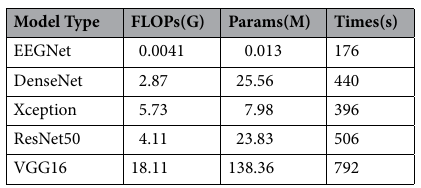
Table 5. FLOPs, Params and times of all